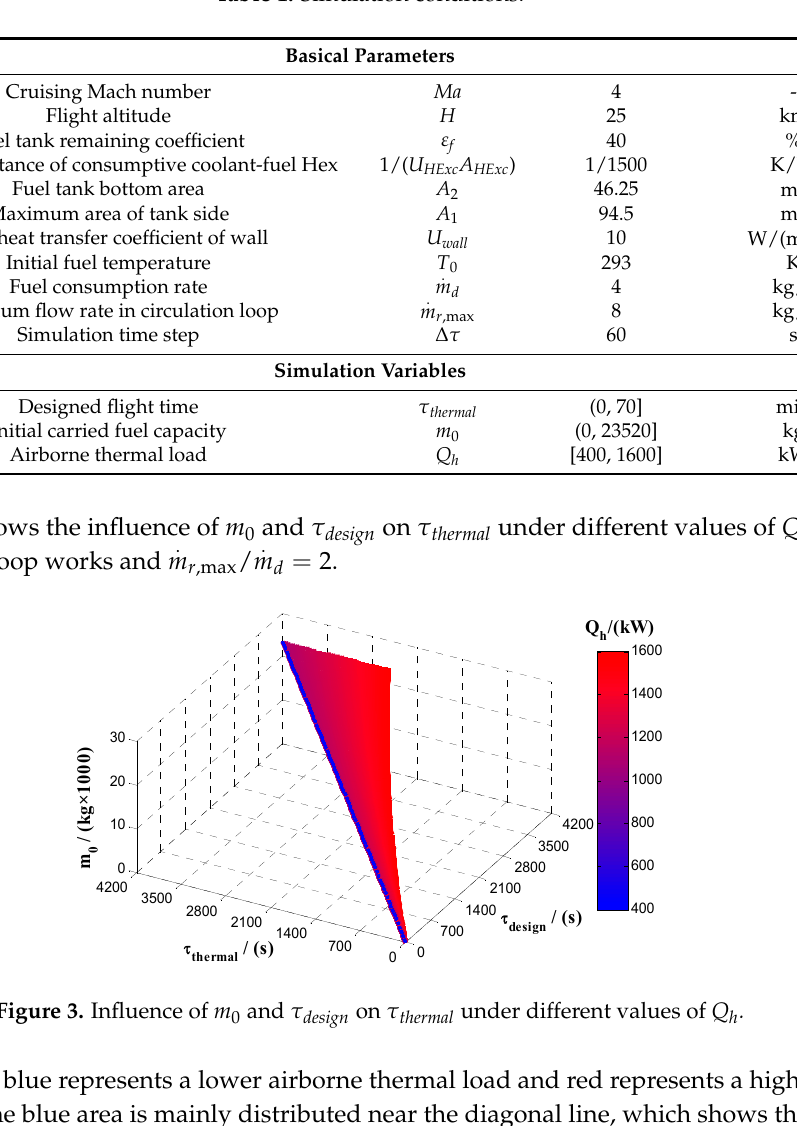
Figure 4. Relationship between m 0 , τ thermal and τ design . The following conclusions can further be drawn: (1) τ design increases with the increase of m 0 under different thermal loads, but their slopes decrease with the increase of heat loads; (2) When